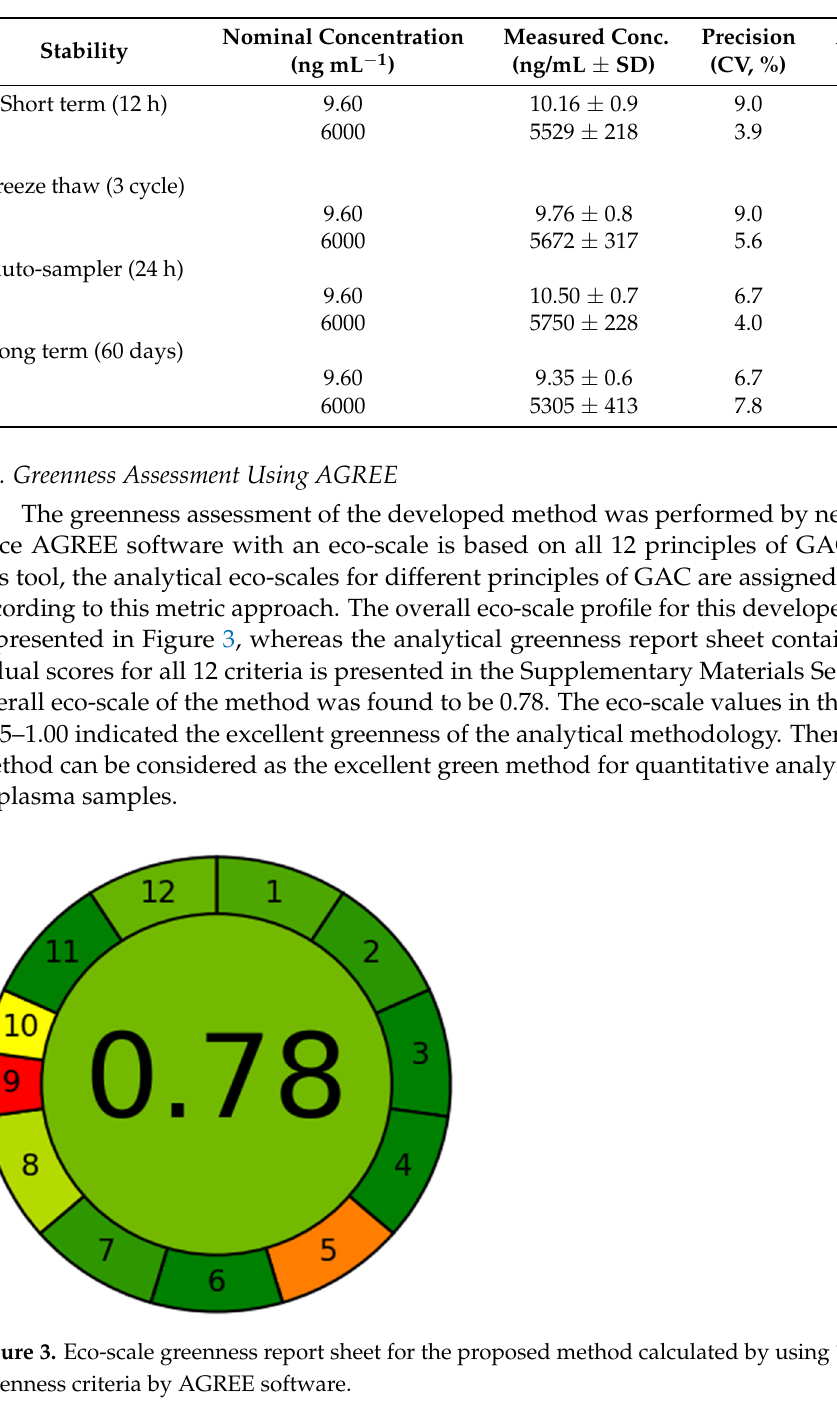
Table 4. Stability data of DFX in different storage conditions and processed samples (n = 5).